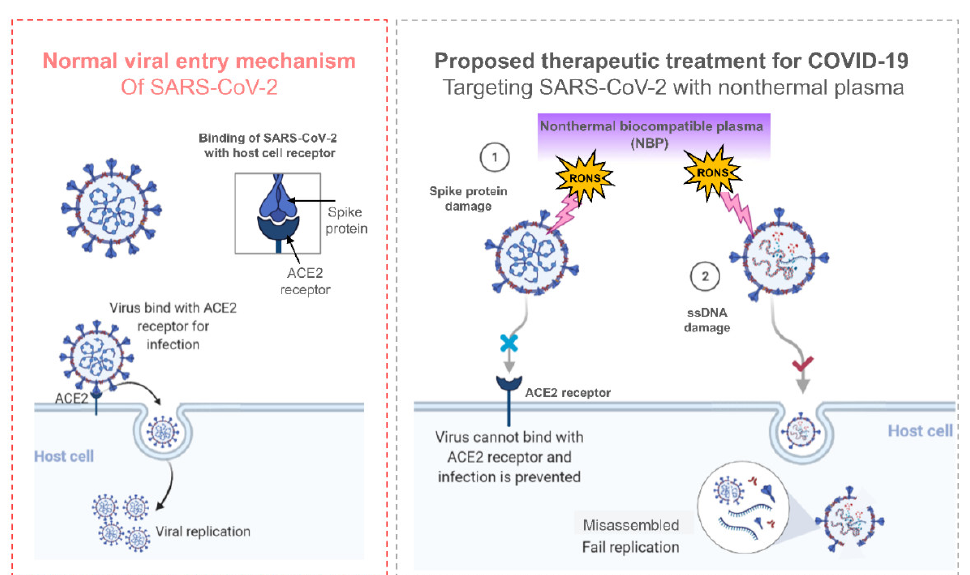
Figure 8. The mechanism by which SARS-CoV-2 normally enters a host cell and the idea behind NTP-based inactivation. NTP-produced RONS bind directly to the surface of virus particles. Due to membrane-bound spike proteins’ improper binding to ACE-2 receptors, they prevent the virus from entering lung cells. Additionally, even though the virus passes through the alveolar plasma membrane, contact viral components are not synthesized in lung cells as a result of genetic information damage. The capsid proteins that protect RNA are decomposed and the molecular binding of RNA is broken [143] .